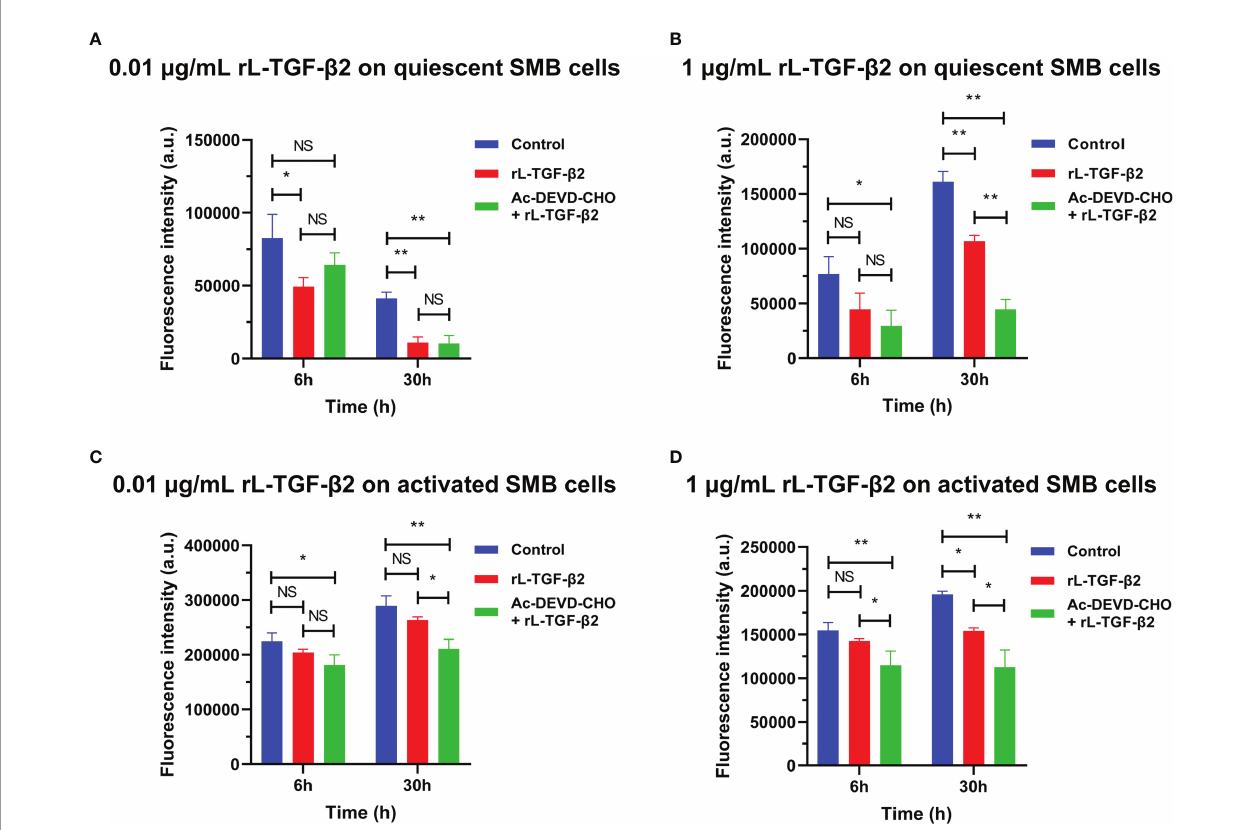
FIGURE 7 | The effect of rL-TGF- b 2 on apoptosis of quiescent and activated SMB cells in lampreys detected by quanti fi cation of caspase-3/7 activity. After 6 or 30 h of incubation, the fl uorescence intensity of the L-TGF- b -treated group, Ac-DEVD-CHO + L-TGF- b co-treated group, and the control group were compared, respectively. All experiments were repeated thrice. The statistical analyses were all performed by ordinary one-way ANOVA followed by Tukey ’ s multiple comparisons test, in which the statistical signi fi cance between the two groups is indicated by the asterisk at the top of the bar chart. *: p < 0.05, **: p < 0.01, NS, Not signi fi cant. (A) The effect of rL-TGF- b 2 (0.01 ug/ml) on apoptosis of quiescent SMB cells. (B) The effect of rL-TGF- b 2 (1 ug/ml) on apoptosis of quiescent SMB cells. (C) The effect of rL-TGF- b 2 (0.01 ug/ml) on apoptosis of activated SMB cells. (D) The effect of rL-TGF- b 2 (1 ug/ml) on apoptosis of activated SMB